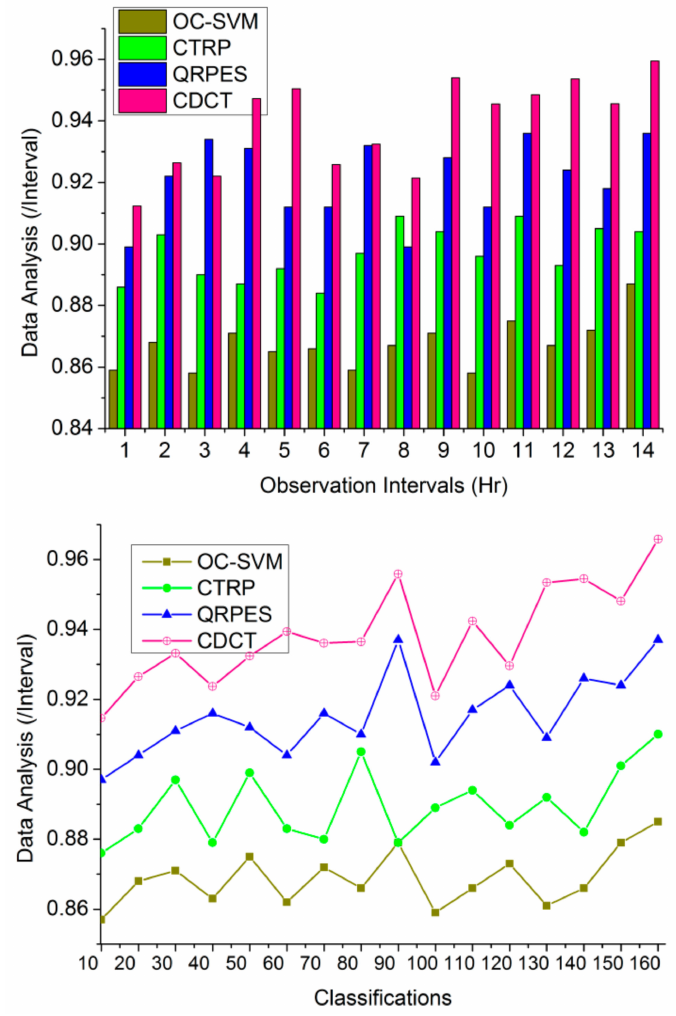
Figure 10. Emission Control Data